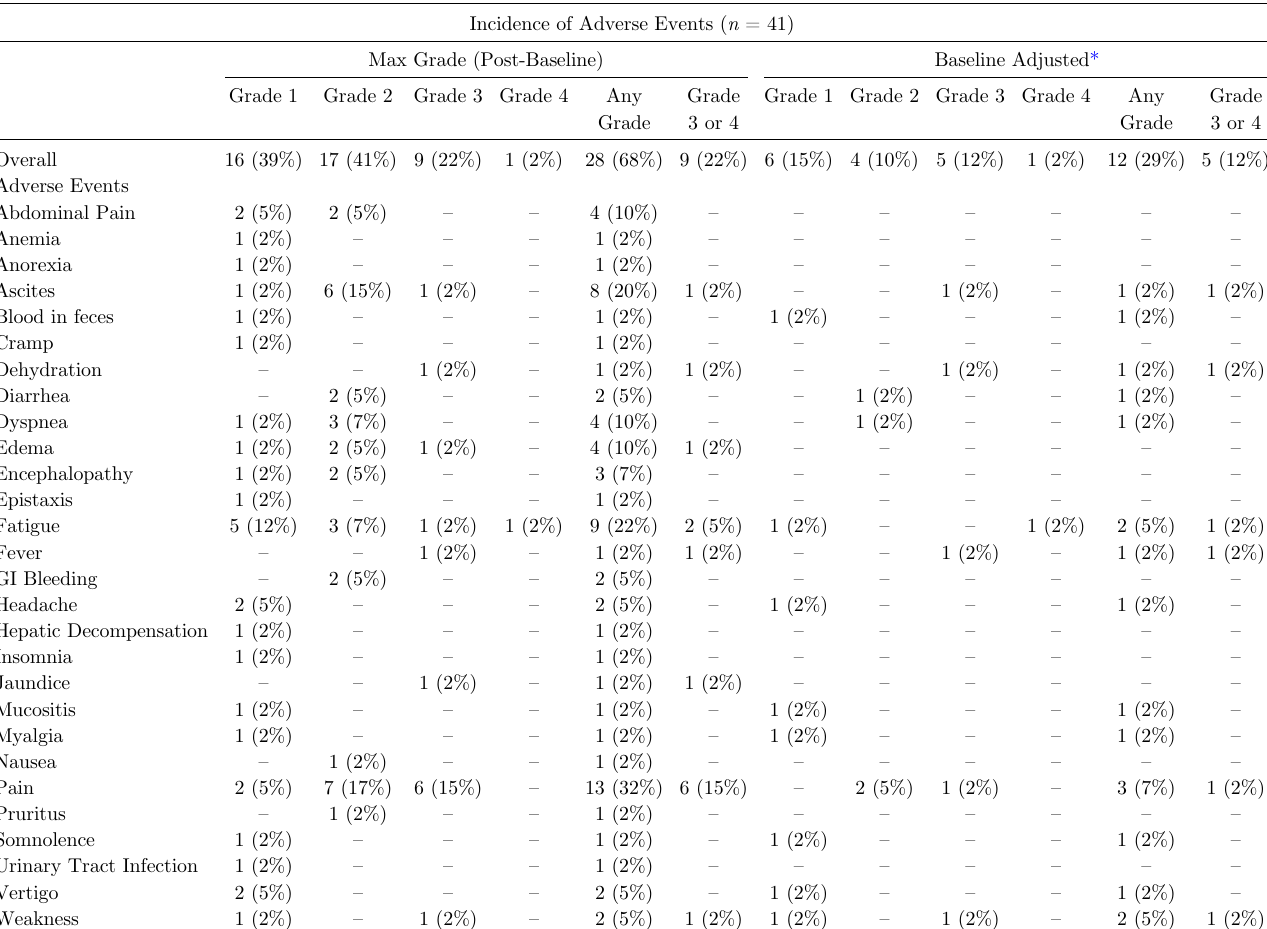
Table 5. Adverse Events Summary – Phase I/II Study ( n = 41). Adverse Events reported by NCI CTCAE grade in patients receiving treatment with the TheraBionic